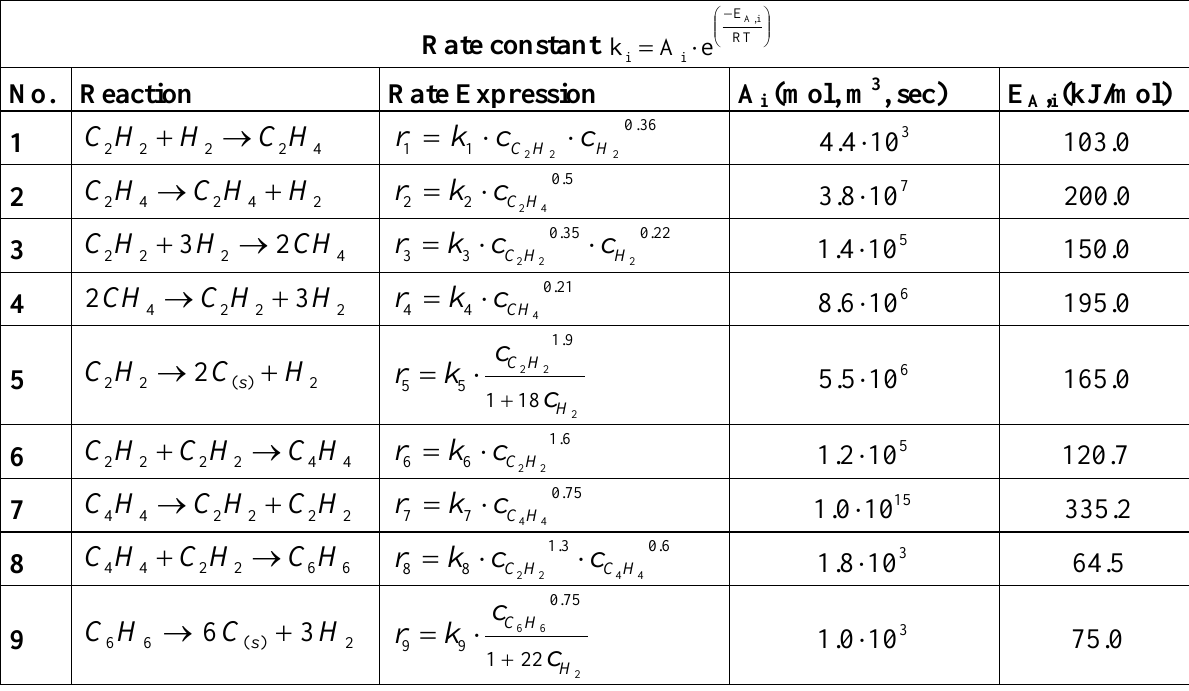
Table 1. Proposed reaction mechanism and kinetic parameters of acetylene